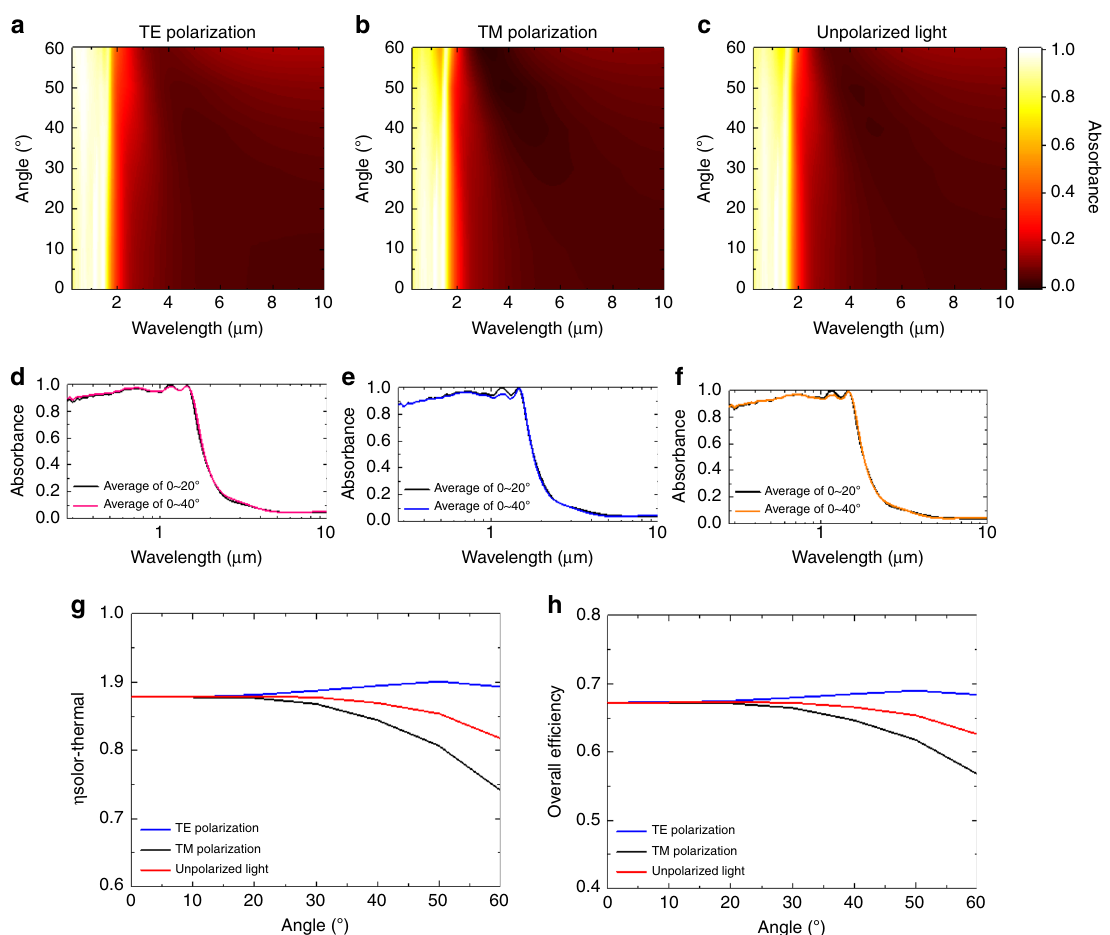
Fig. 3 Omnidirectional solar-thermal energy conversion capability of SGM absorber. a – c Angle-dependent absorption spectra of H2 SGM absorber with 30-nm graphene metamaterial fi lm under a TE-polarized, b TM-polarized, and c unpolarized light, respectively. d – f Averaged absorbance over incident angles from 0° to 20° and 0° to 40° of d TE-polarized, e TM-polarized, and f unpolarized light. g , h The calculated g solar-to-thermal ef fi ciencies and h overall ef fi ciencies of H2 SGM absorber with a 30-nm graphene metamaterial fi lm under TE-polarized, TM-polarized, and unpolarized light at various angles of incidence and the working situation of T 0 = 298 K, T A = 1273 K, and C =